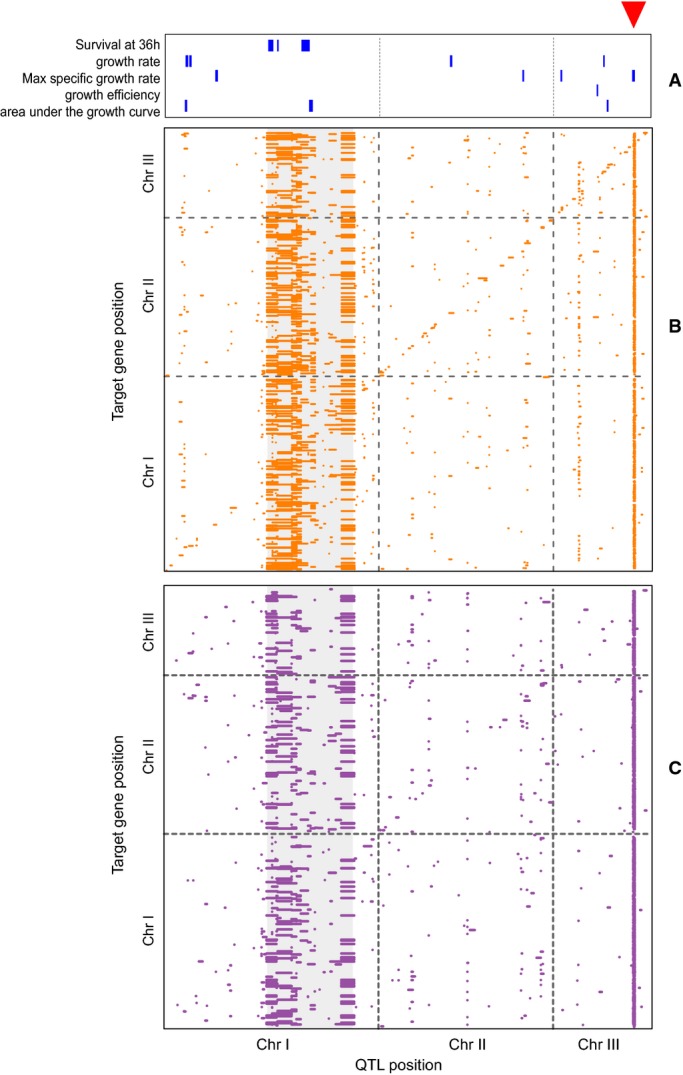
QTL maps for growth traits, sense expression, and antisense expressionThe red triangle indicates the position of the Chromosome III hotspot (swc5
locus).Growth QTL (10% FDR) obtained from high-resolution growth phenotyping in liquid culture
and the survival rate at 36 h.eQTL map for 6,464 expression traits (all annotated genes, coding, and non-coding). Each dot
represents a significant eQTL (5% FDR) where locus positions are represented on the
x-axis and gene positions on the y-axis. The zone in gray
corresponds to the Chromosome I inversion.aseQTL map for 4,133 antisense expression traits.